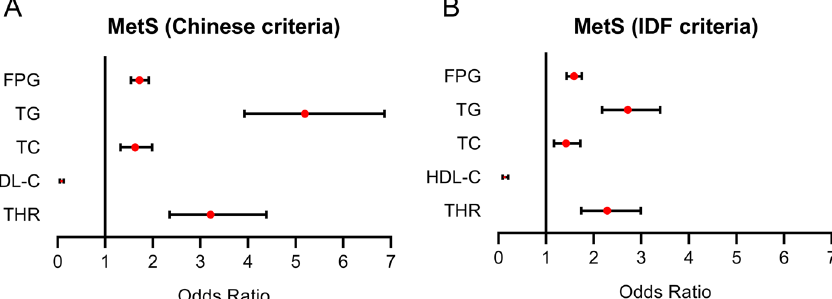
Figure 1. Logistic regression results of laboratory parameters for MetS predicting. ( A ) MetS according to the Chinese criteria. ( B ) MetS according to the IDF criteria. FPG fast plasma glucose, HDL-C high-density